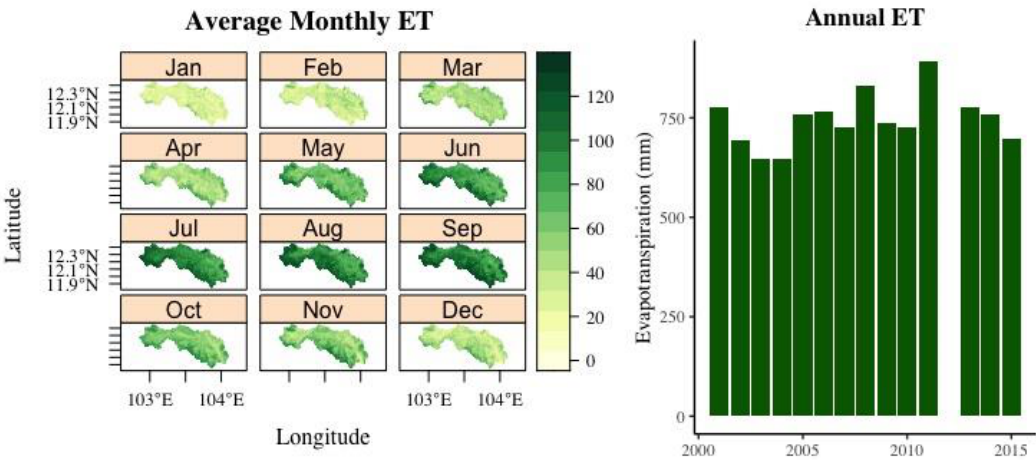
Figure 6. Average monthly ( left ) and annual evapotranspiration ( right ) in Pursat River basin (drainage area at Bak Trakuon outlet) from 2001 to 2015 obtained from MODIS ET.